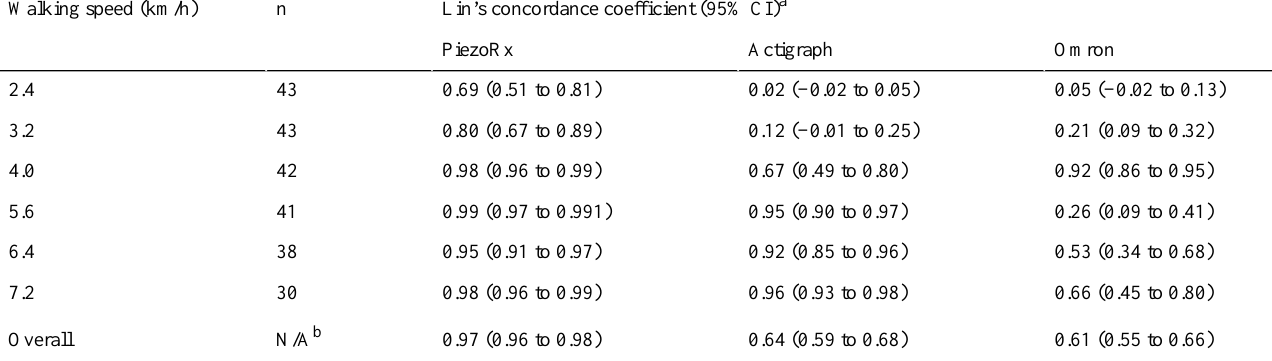
Table 3. Lin’s concordance